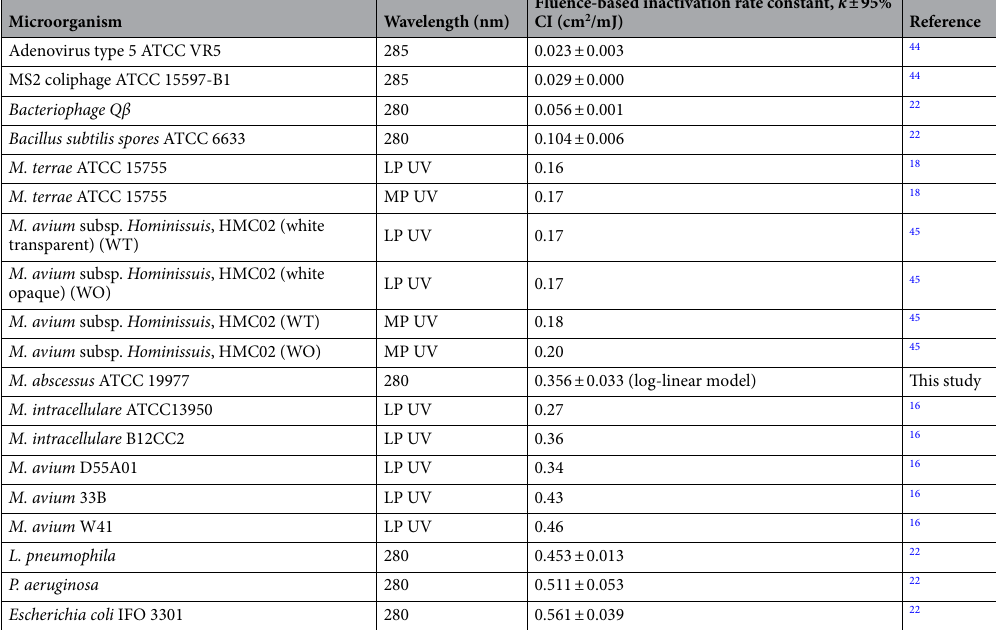
Table 2. Comparison of fluence-based inactivation rate constants from recent UV inactivation studies for selected NTM and microorganisms relevant to drinking water disinfection. M .